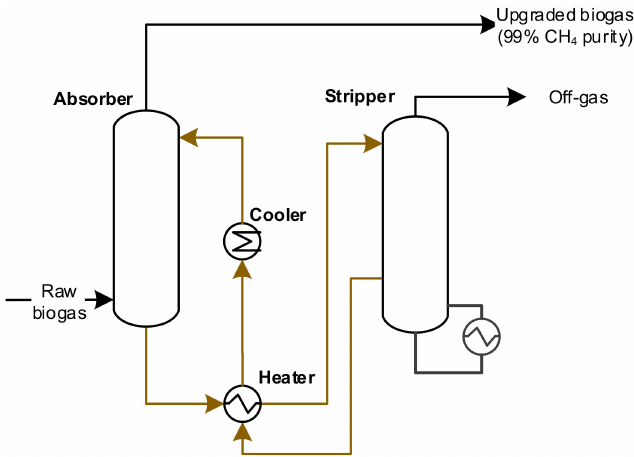
Figure 7. Process flow diagram for chemical scrubber using an amine-based compound as the solvent. Adapted from Muñoz et al.